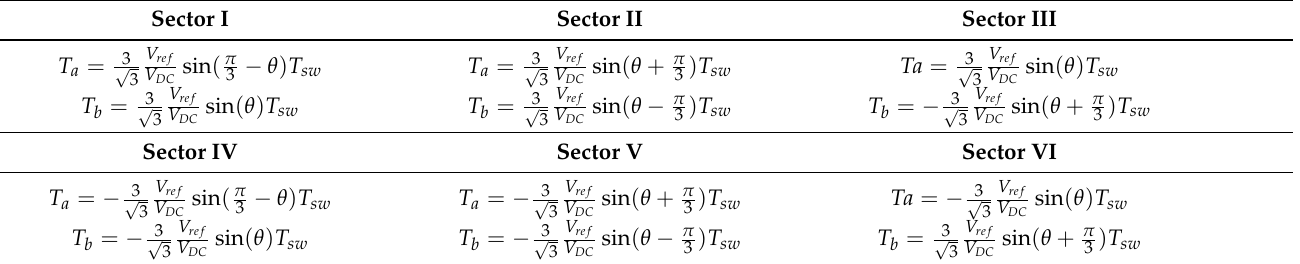
Table 2. Equations for calculating times in each